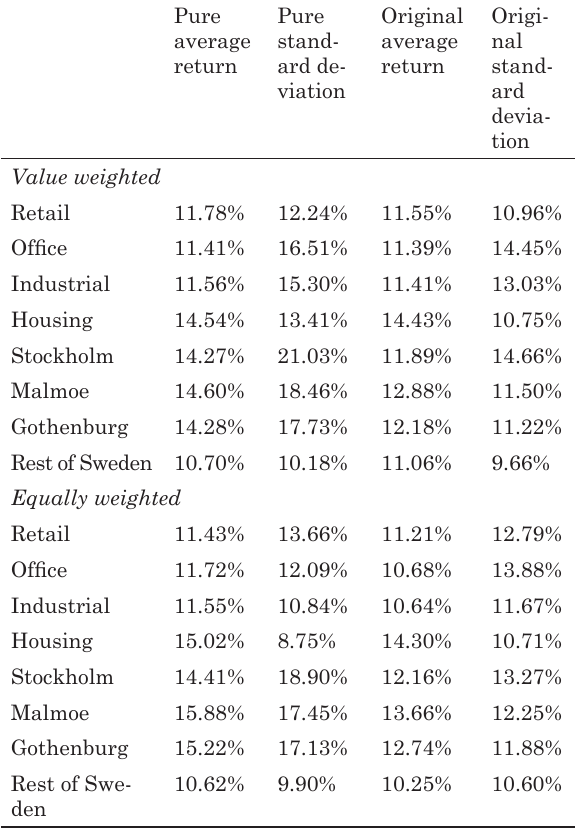
Table 4. average return and standard deviation